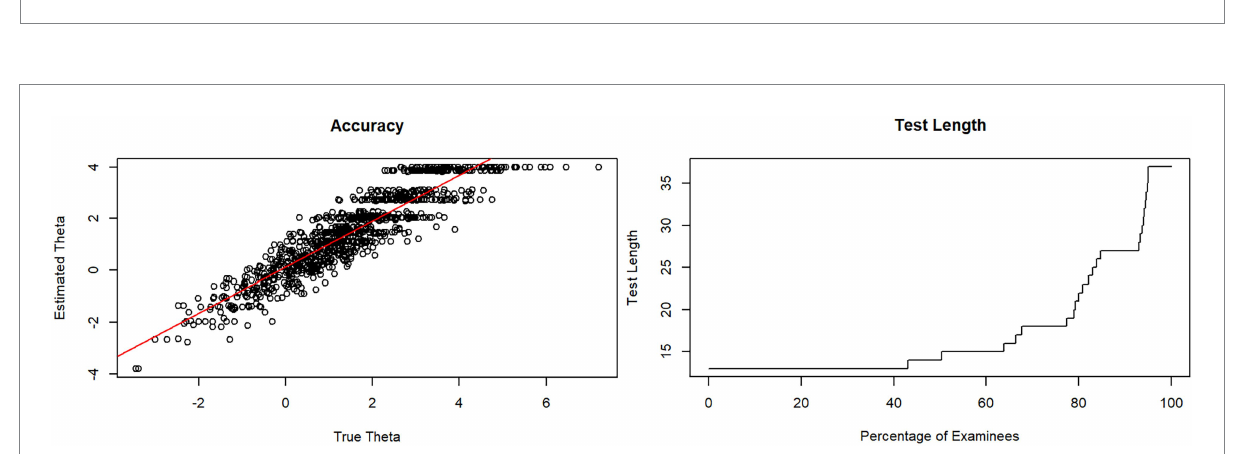
FIGURE 2 Test length and accuracy of ZasM-CAT in a simulation of 1,000 test executions with stopping rules SE = 0.5 and length = 24